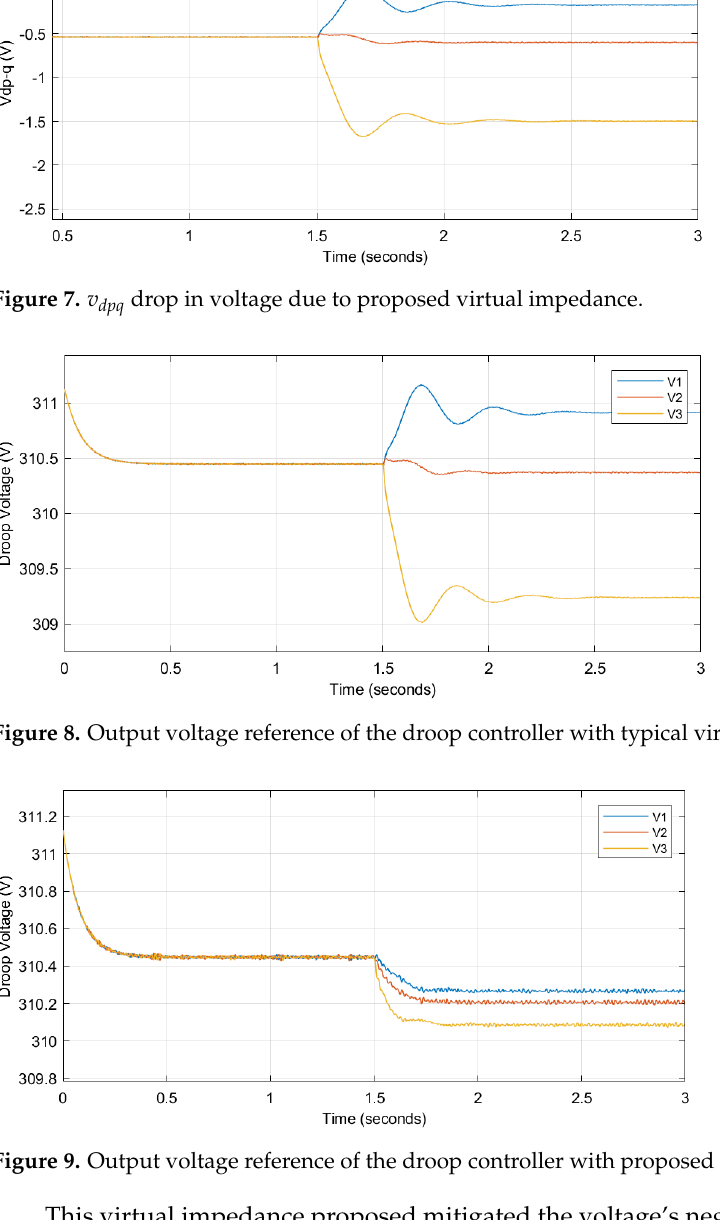
Figure 9. Output voltage reference of the droop controller with proposed virtual impedance.